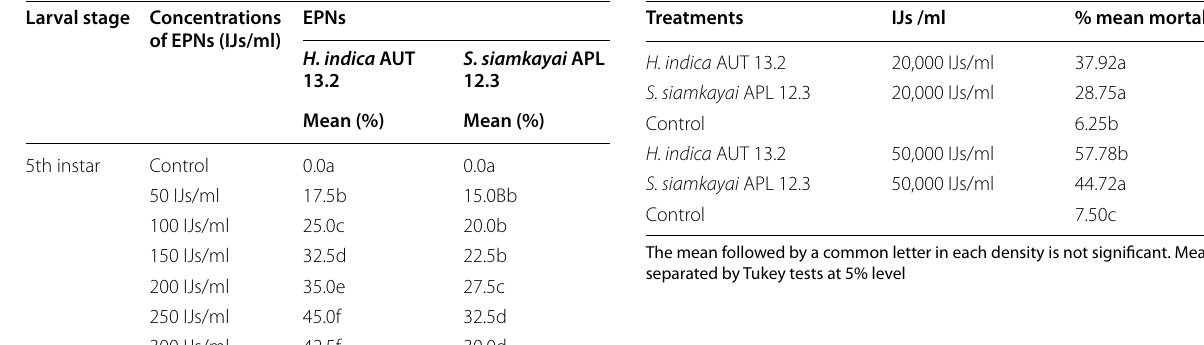
The means in each column followed by a common letter are not significantly different by the Duncan multiple range tests at 5% level